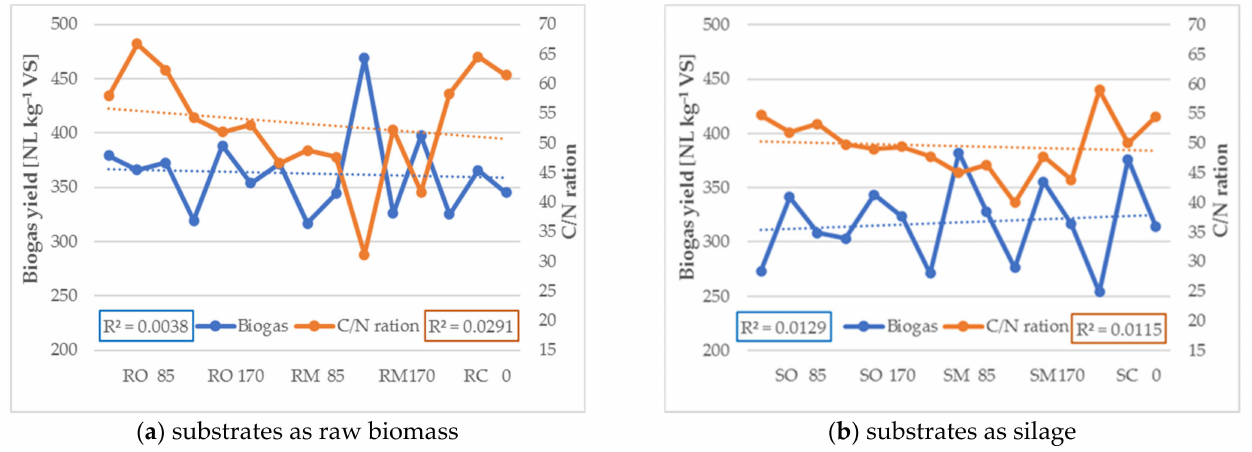
Figure 1. Correlation of biogas yields of substrates with a C/N ratio of raw ( a ) and silage ( b ) from Silphium perfoliatum .